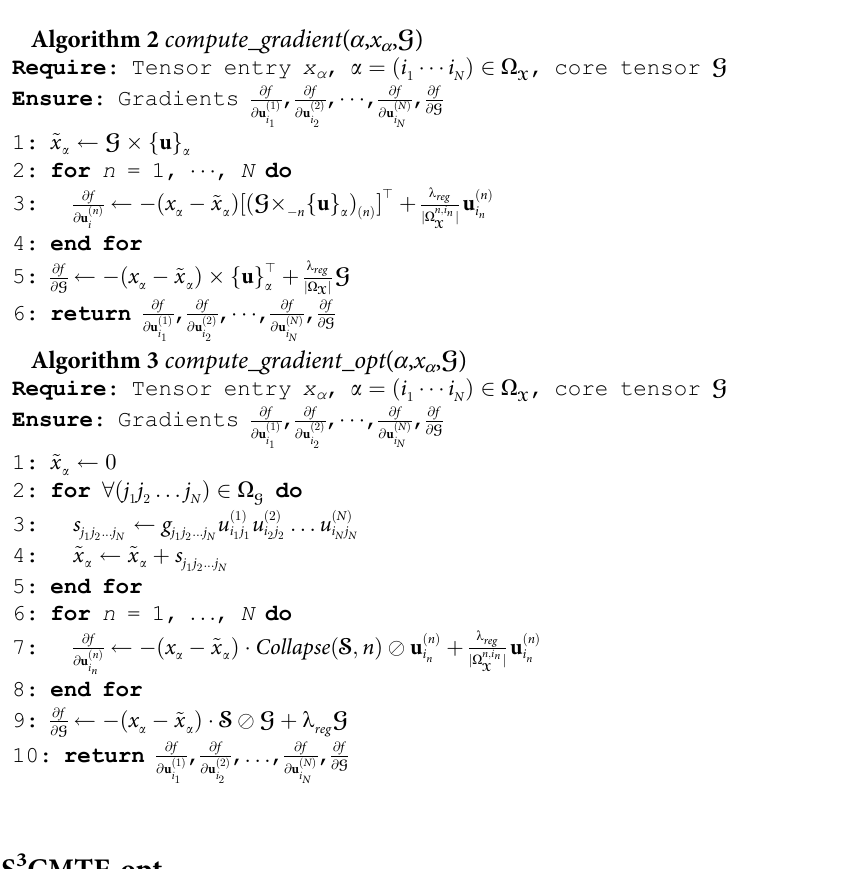
Algorithm 2 compute_gradient ( α , x